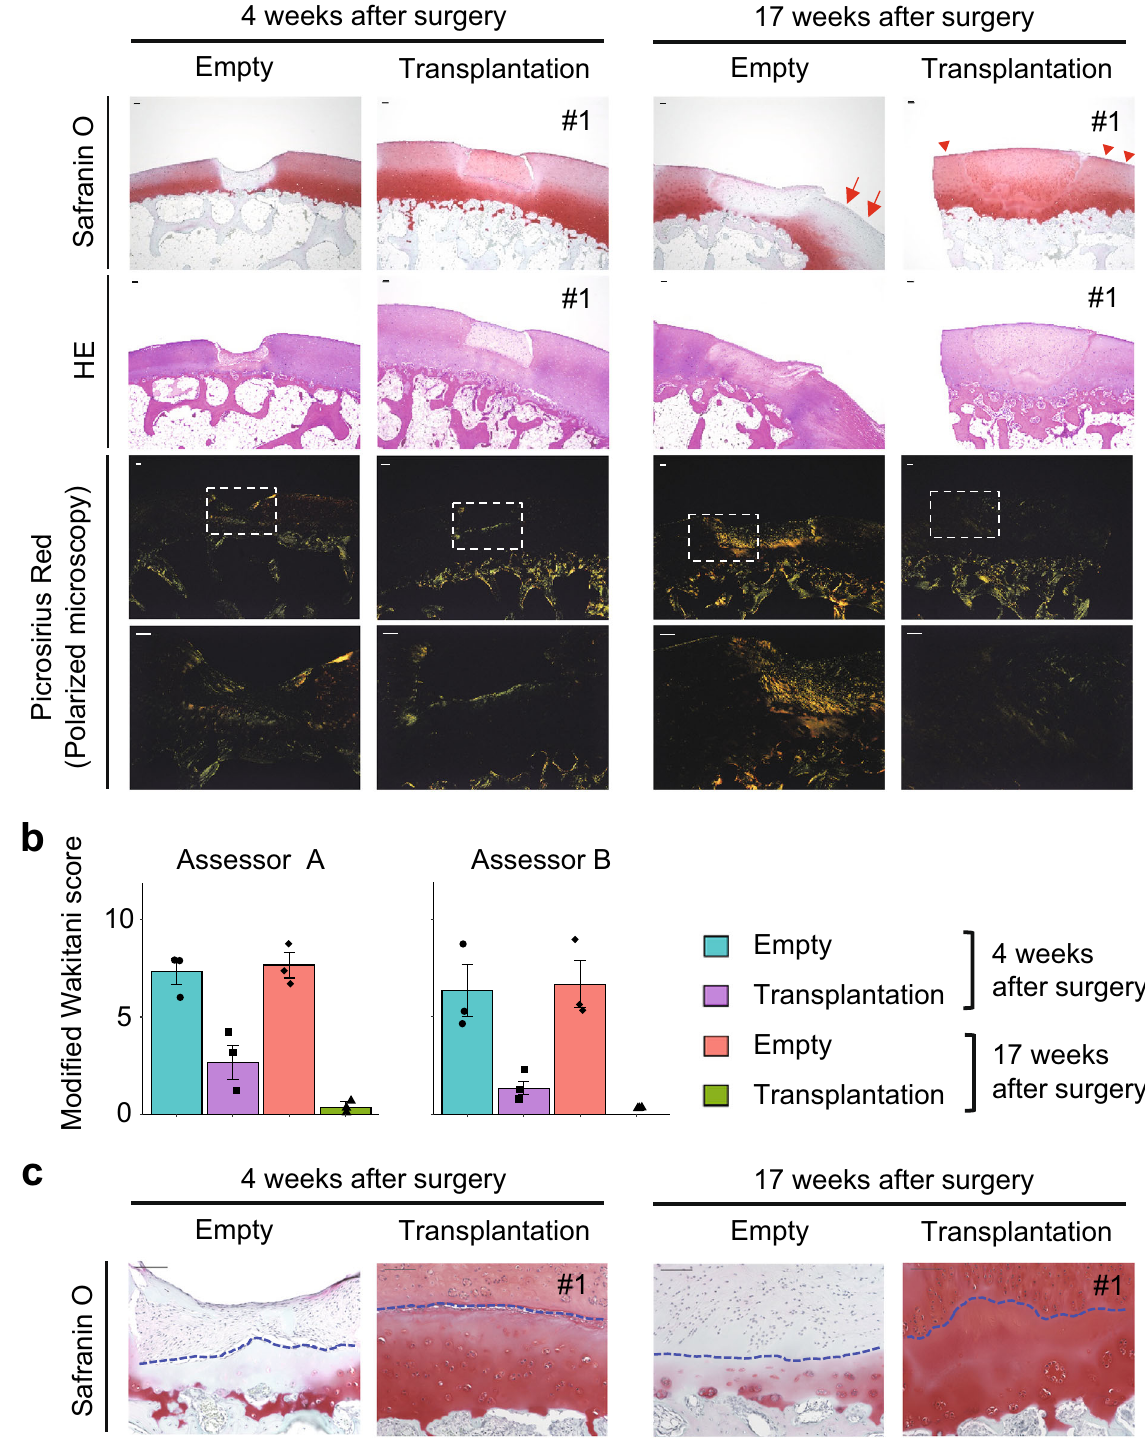
Fig. 3 | Qualities of repaired tissue in chondral defects. a Samples were har- vested 4 or 17 weeks after transplantation. Semi-serial sections were stained with Safranin O, HE, or picrosirius red. Sections stained with picrosirius red were observed under a polarized microscope. A magni fi cation of the boxed regions that cover repaired tissue and native articular cartilage in the third row is indicated in the bottom row. Scale bars, 100 µ m. b Sections stained